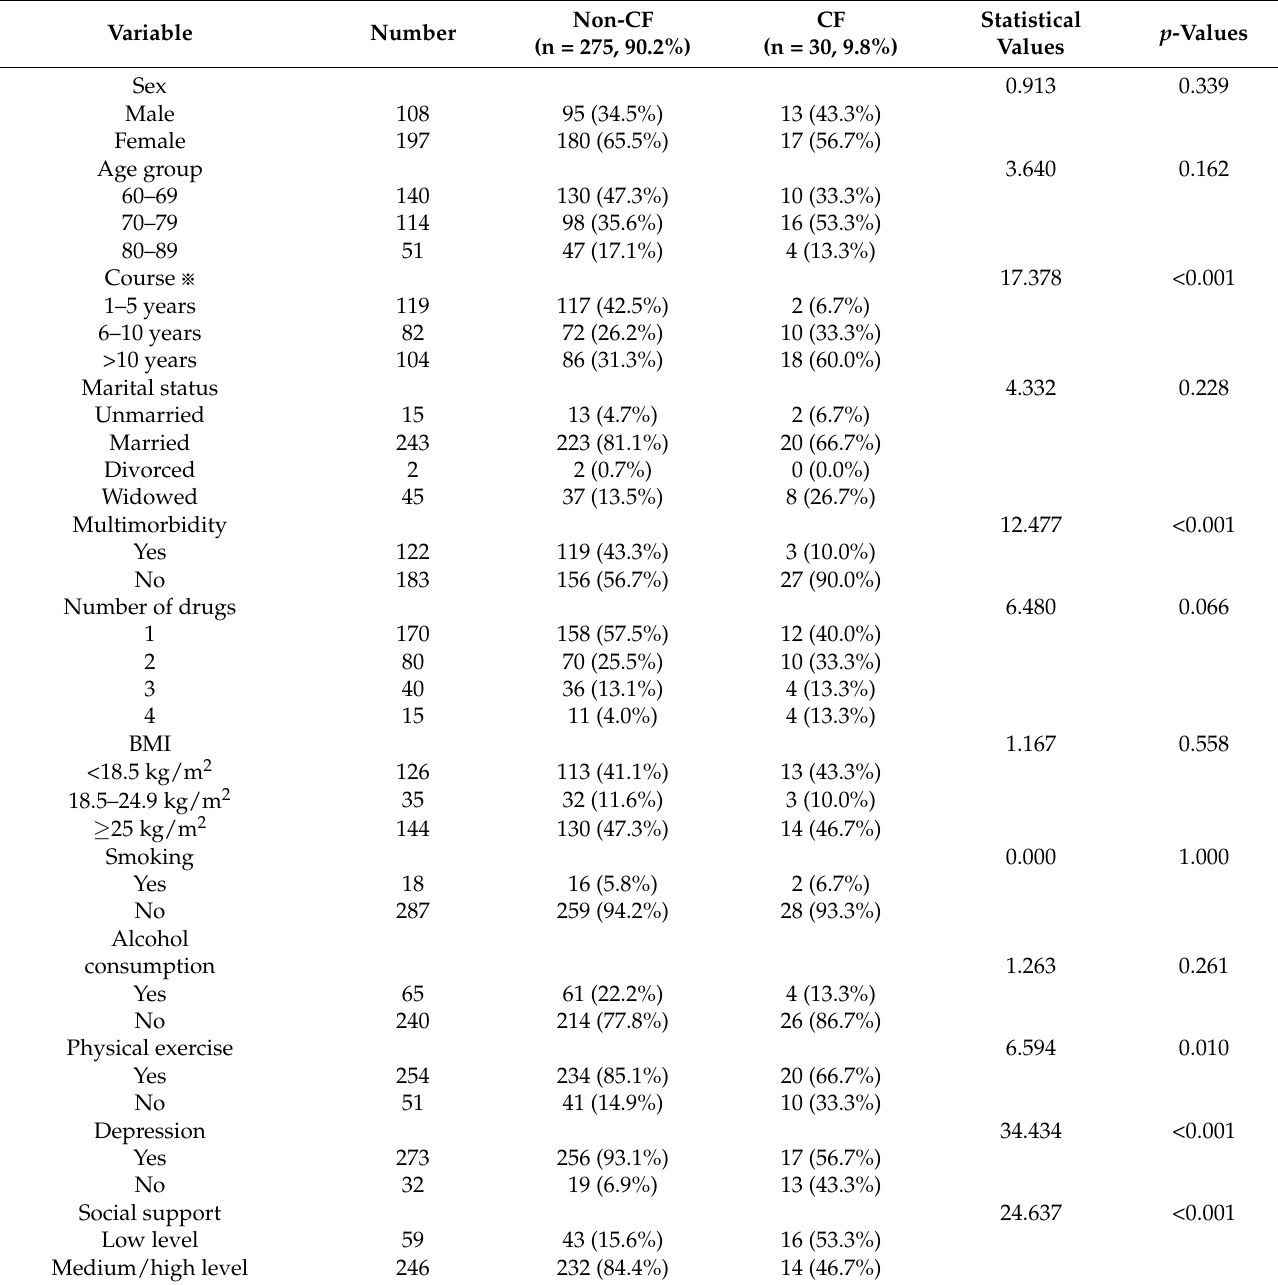
Table 1. General demographic data and univariate